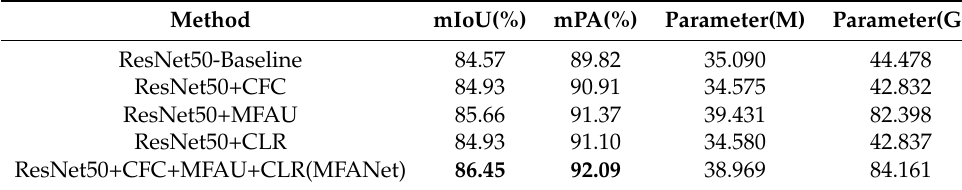
Table 3. The performance comparison of the networks using the proposed modules in turn. ‘ResNet50-Baseline’ means the segmentation network with three types of modules: SE, GAU, and RRB, and it uses ResNet50 as the backbone. ‘CFC’ means using CFC module to replace the SE module. ‘MFAU’ means using MFAU module to replace the GAU module. ‘CLR’ means using CLR module to replace the RRB module (bold represents the best